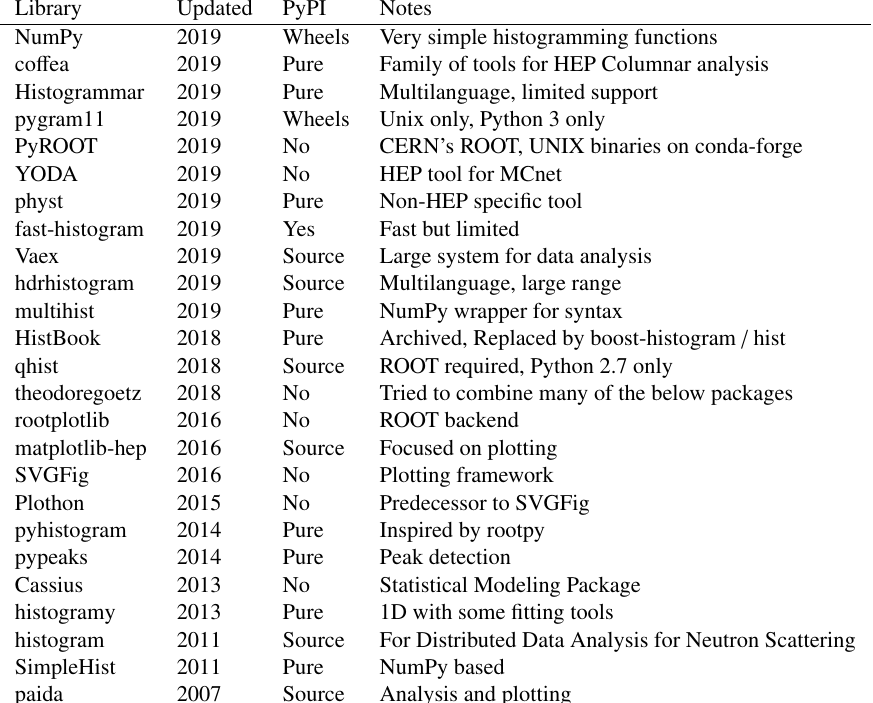
Table 1. Histogram libraries for Python. For the PyPI column, “Pure” means the library is pure Python, “Wheels” means it is compiled but binary wheels are available, “Source” means the code is there, but must be compiled and may require other dependencies, and “No” means it is not hosted on PyPI. Old projects that predate universal (pure python) wheels may be incorrectly listed as “Source”. Ordered by last update time, compiled near the end of